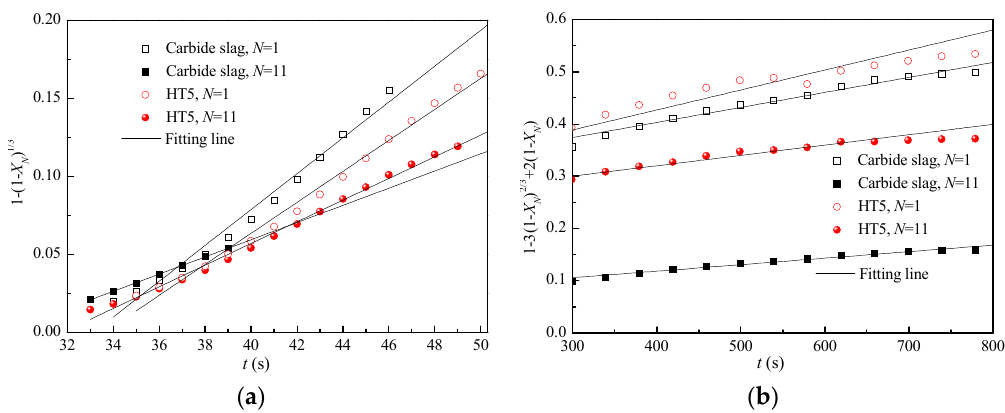
Figure 10. Carbonation kinetics curves of HT5 at ( a ) the chemical reaction-controlled stage and ( b ) the diffusion-controlled stage fitted by the shrinking core model (carbonation in 15% CO 2 /N 2 at 700 °C for 20 min, calcination in 100% N 2 at 850 °C). Table 3. Apparent reaction rate constants of HT5 and carbide slag after fitting. Samples.